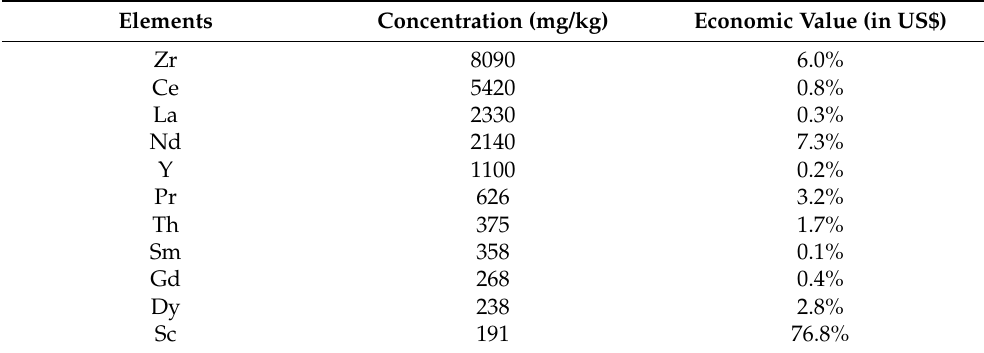
Table 3. Zirconium and rare-earth elements composition of the ore sample and their economic value in the silicate-based ore.